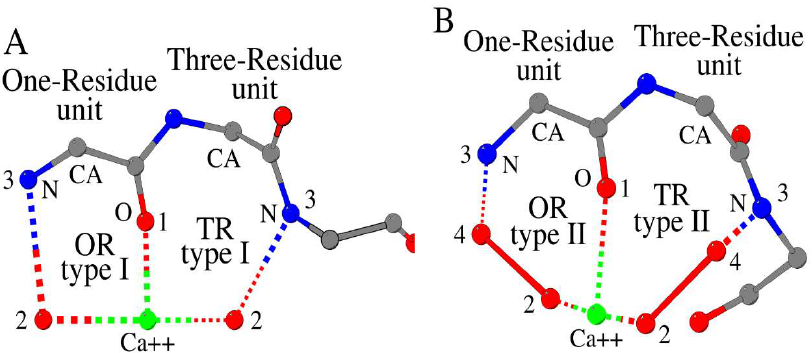
Figure 1. Metal cation-binding One-Residue (OR) and Three-Residue (TR) units, type I ( A ) and type II ( B ), in proteins. The di ff erence between recognition by type I and type II is that the bound Ca 2 + atom is linked to the main-chain nitrogen atom “3” through one oxygen atom (“2”, type I) or two oxygens atoms (“2” and “4”, type II). The line between atoms “2” and “4” is not a covalent bond, but a rigid connection between two atoms of the same amino acid or a ligand, or two adjacent amino acids (n) and (n − 1) / (n) / (n + 1). Amino acid atoms, water molecules and ligand atoms (carbon as gray, nitrogen as blue and oxygen as red) and cations as green are shown using the ball-and-stick model.